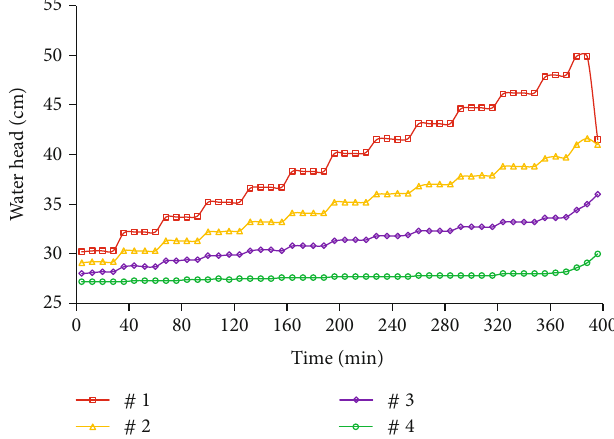
Figure 8: Process curve of water head of di ff erent piezometers located in soil numbered F.